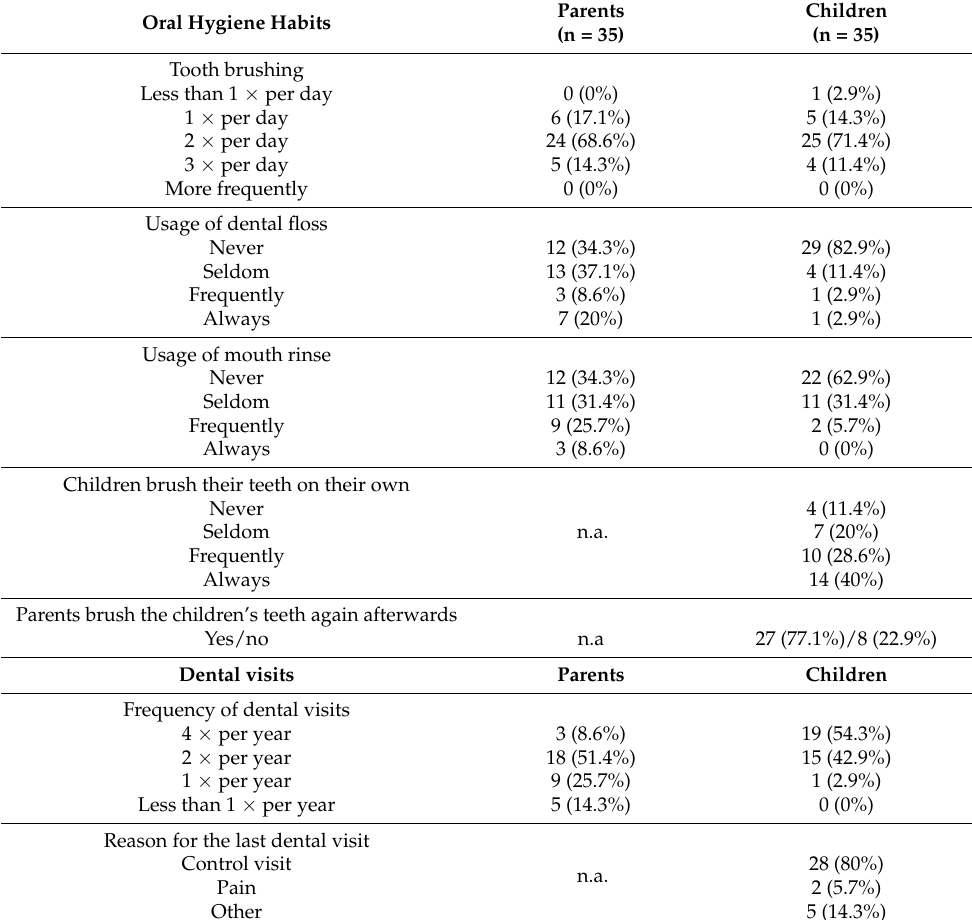
Table 4. Oral hygiene habits and dental visits of the children and the accompanying